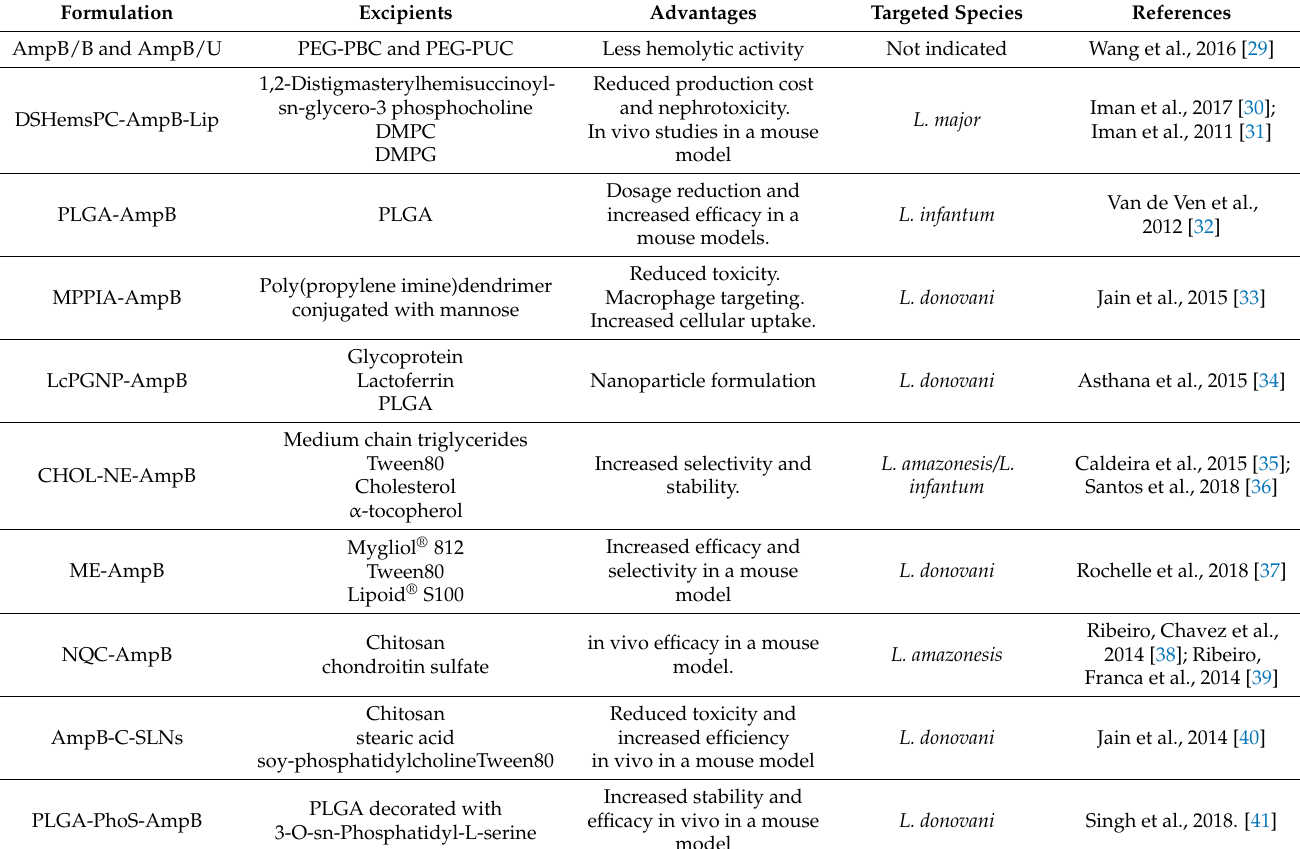
Table 3. Parenteral formulations of AmpB in preclinical